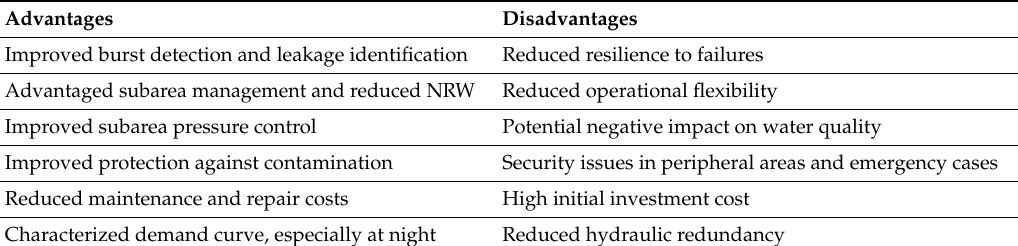
Table 1. Main advantages and disadvantages of district metered areas